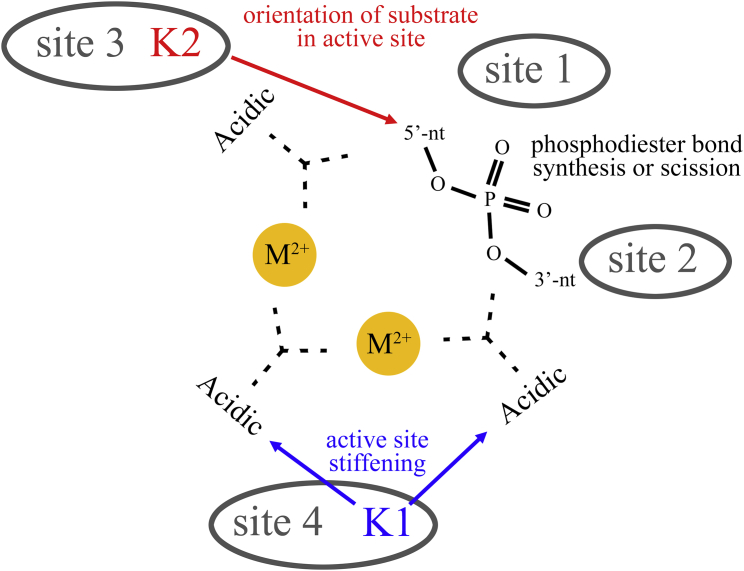
Structural Model Recapitulating Positions and Possible Roles of K1- and K2-like Positive Charges in the Active Site of Two-Metal-Ion EnzymesIn the active site, strictly conserved acidic residues (“acidic”) coordinate two divalent ions (M2+) that catalyze synthesis or scission of phosphodiester bonds in the DNA/RNA substrate. “5′-nt” and “3′-nt” indicate nucleotides on the 5′ and 3′ side of the reaction site, respectively. In all enzymes discussed in this work, the active site is completed by the presence of two positively charged elements that correspond to the group II intron K1 and K2 ions. These structural elements are either basic amino acids or monovalent cations. These elements likely contribute to rigidify the active site for optimal M2+ binding and to orient the substrate for catalysis. Sites 1, 2, and 3 are structural positions previously identified by Steitz and Steitz (1993), and site 4 is a structural site identified as described in the main text (see the Results section). Sites 3 and 4 encompass K2- and K1-like residues, respectively.